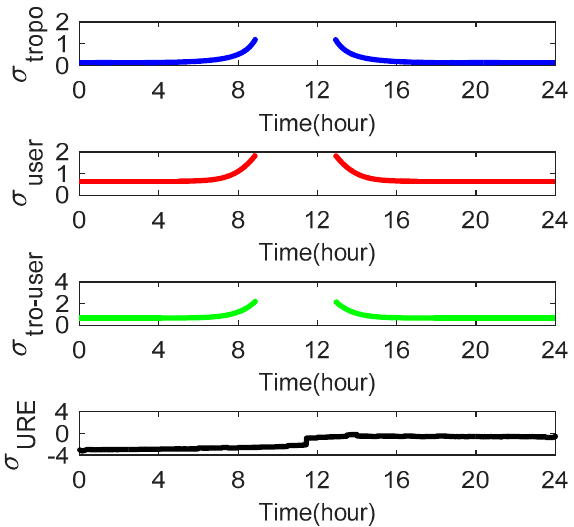
Figure 10. The tropospheric delays σ tropo,i , user errors σ user,i and σ URE of satellite C06 over one day as seen from the receiver at Wuhan University.